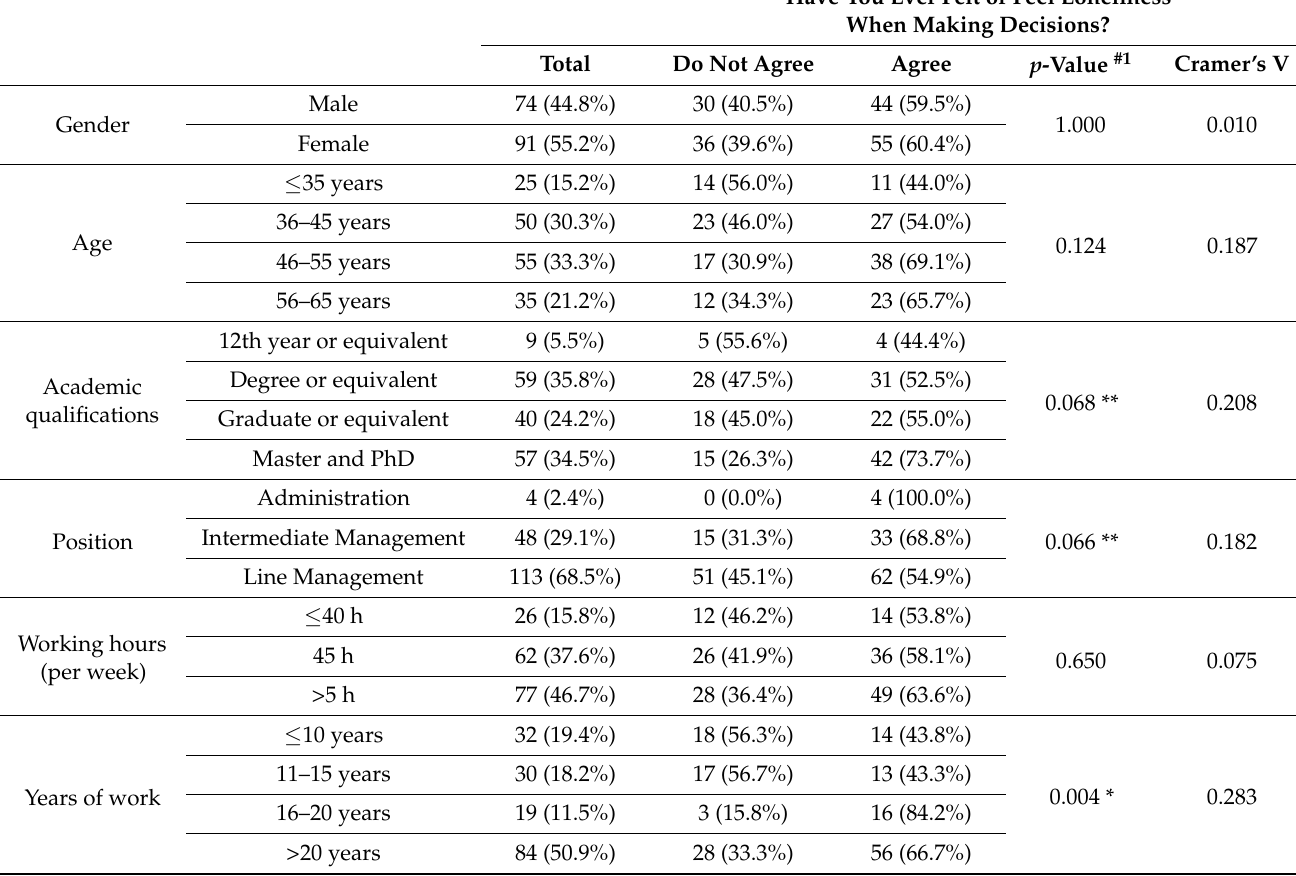
Table 5. Relationship between the sociodemographic variables and the feeling of loneliness (agree and do not